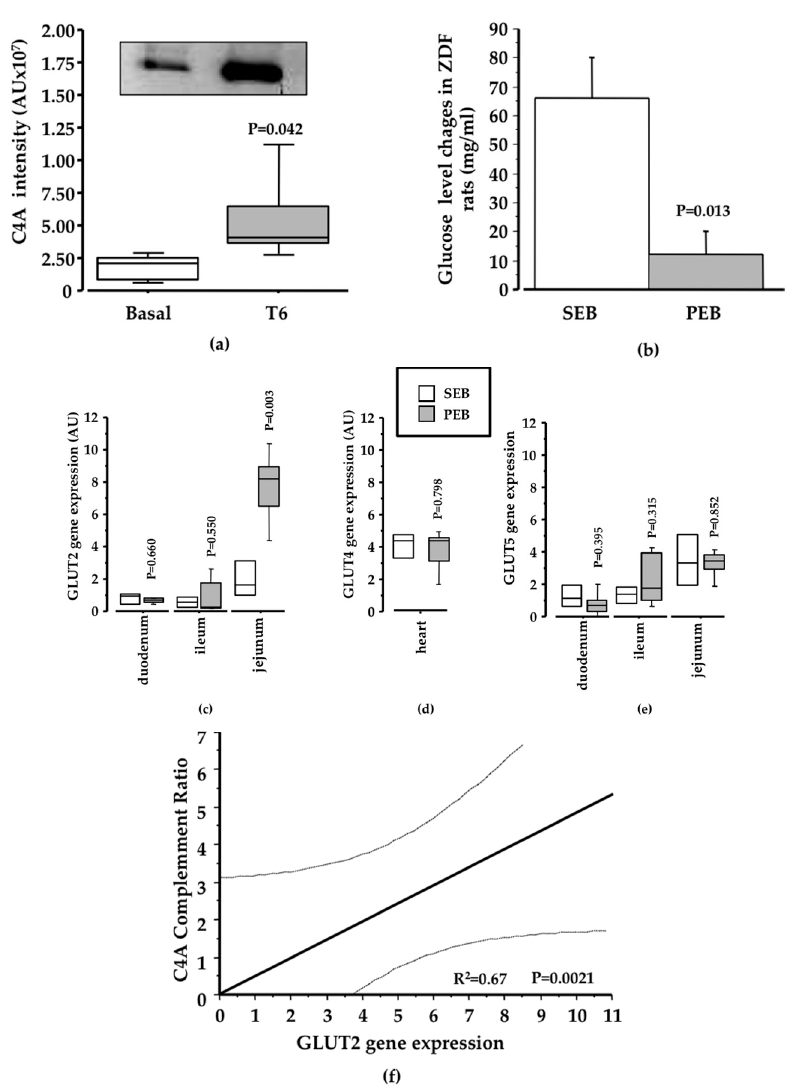
Figure 5. Results validation. ( a ) C4A profile in ZDF rat samples. Box-plot and representative western blot image showing changes in C4A intensity in ZDF rats supplemented with a pinitol-enriched beverage ( N = 5; 1.21-fold change; P = 0.04); ( b ) In ZDF rats, the blood glucose level change after SEB intake was significantly higher than blood glucose level changes after four weeks of PEB intake ( N = 5; P = 0.01); ( c ) Changes in GLUT2 levels. Box-plot diagram showing the change of the gene in the small intestine. A significant reduction in GLUT2 gene expression in the jejunum of ZDF diabetic rats supplemented with pinitol was achieved when compared with the intake of a sucrose-enriched beverage ( N = 9; P = 0.003); ( d ) No change was observed in GLUT4 after pinitol-enriched beverage intake; ( e ) No change in GLUT5 was achieved after pinitol-enriched beverage intake; ( f ) A significant positive correlation was observed between the increase of C4A intensity and the level of GLUT2 achieved ( P = 0.002).